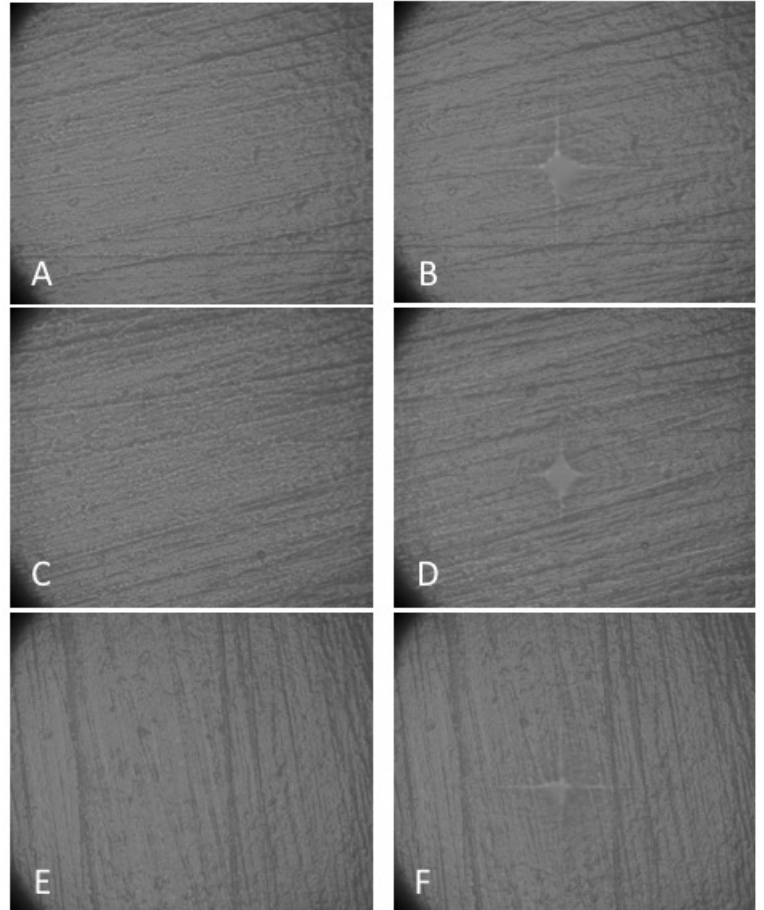
Figure 3. Photomicrographs of resin nano ceramic (Lava ™ Ultimate) before and after immersion in acidic drink for 7 and 28 days (40× magnification). ( A , B ) Before immersion; ( C , D ) after immersion in acidic drink for 7 days, ( E , F ) after immersion in acidic drink for 28 days.